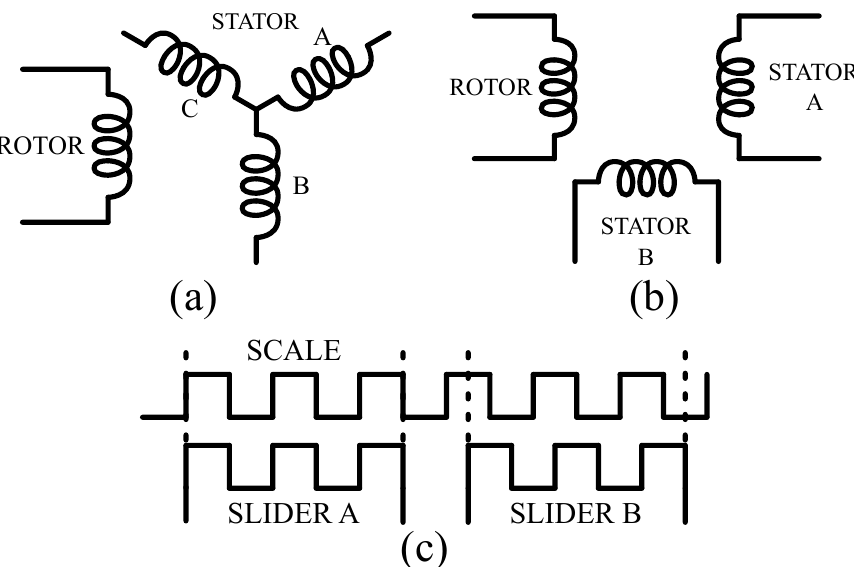
Figure 1. Electromagnetic sensor equivalent circuits: ( a ) synchro, ( b ) resolver, and ( c )